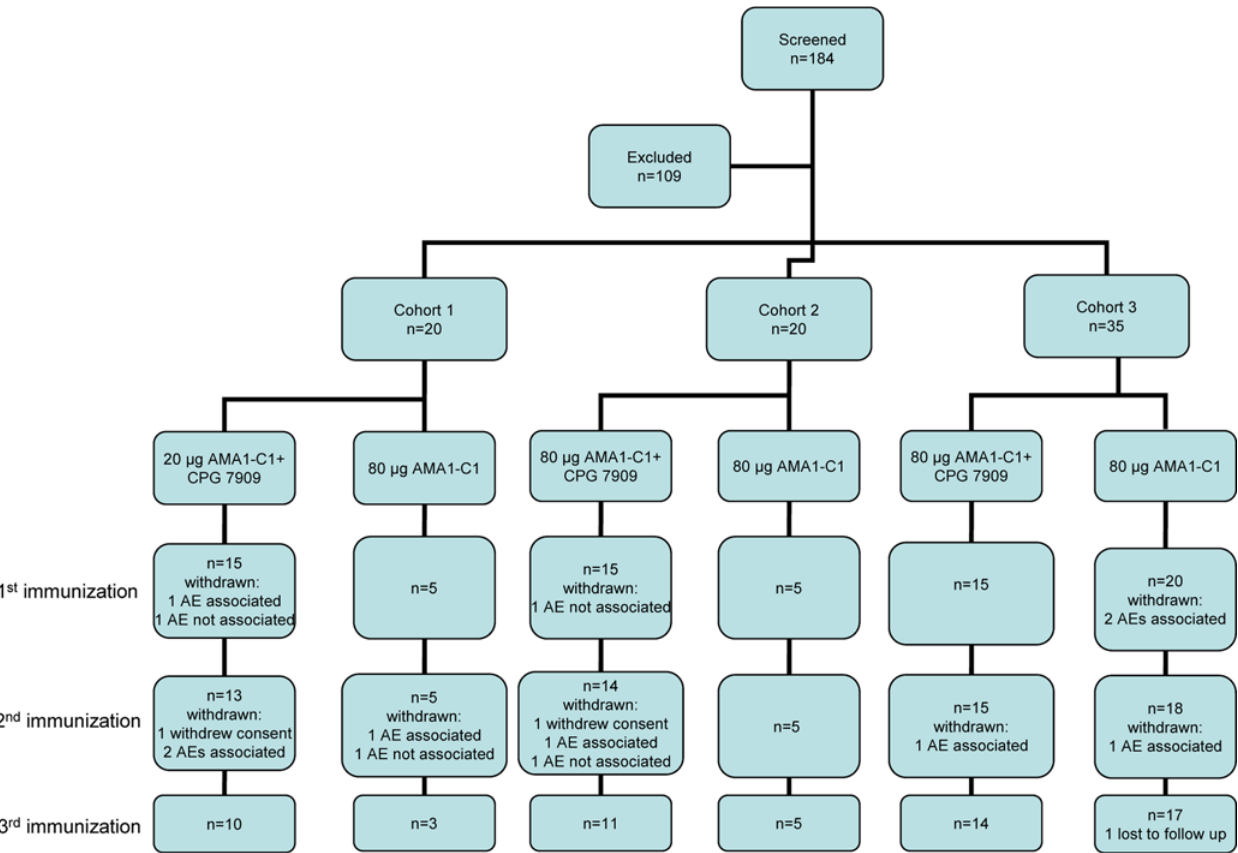
Figure 1. Participant Flow. Reasons for exclusion: Abnormal labs (48: 28 positive ANA, 9 positive RF, 1 positive anti-dsDNA, 10 other) Medical history (21) No show (19) Other (21).